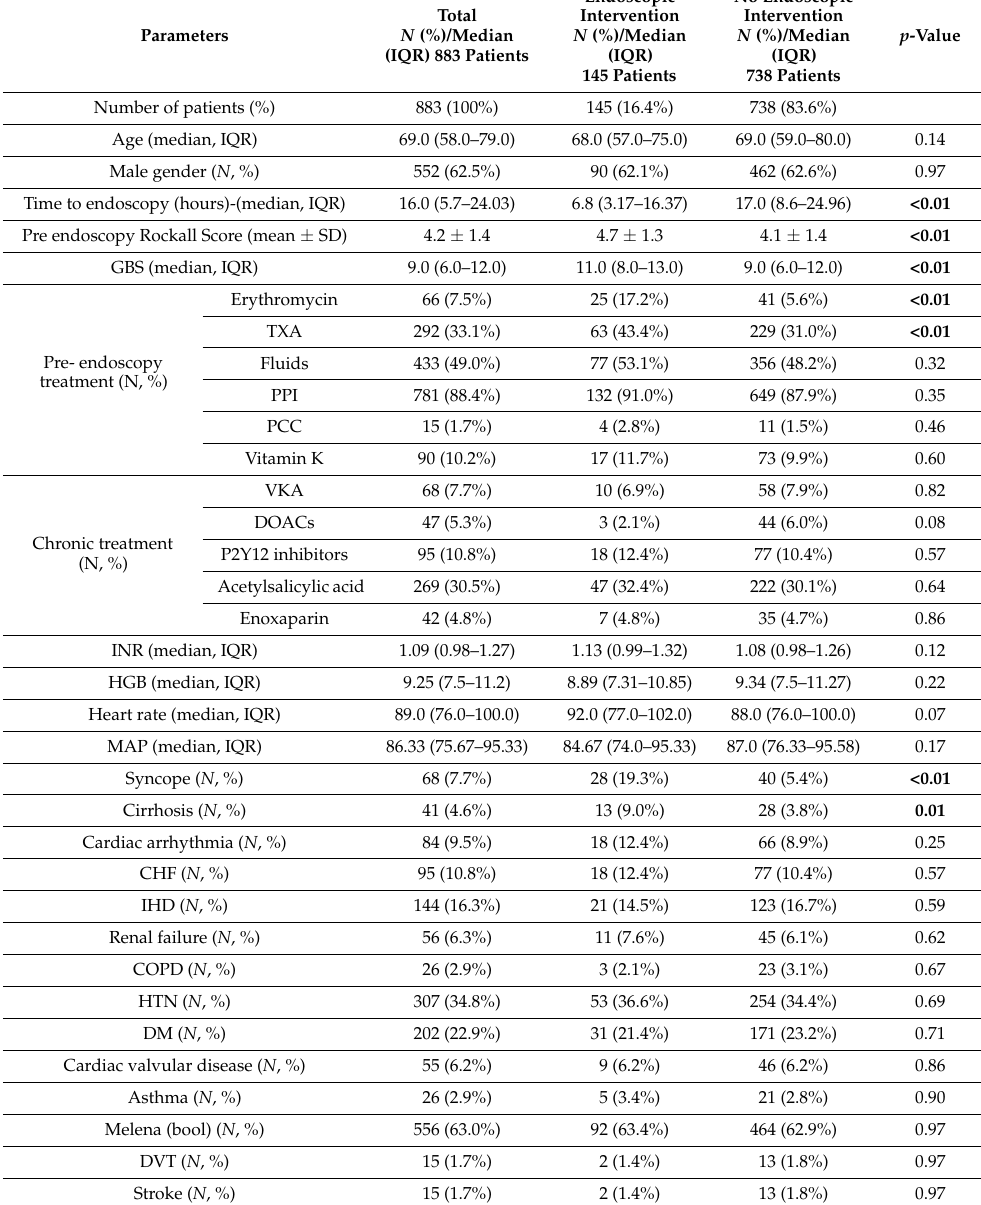
Table 1. Clinical characteristics of the included